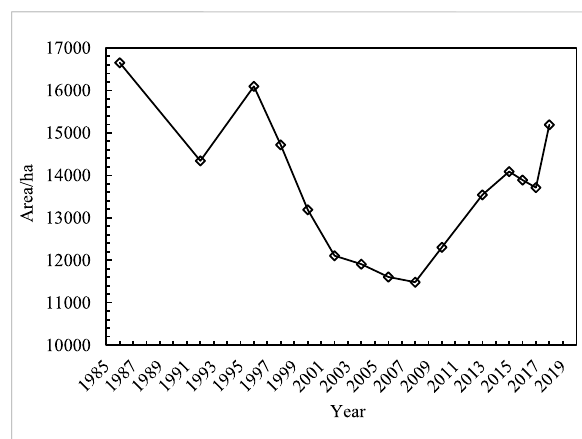
FIGURE 10 Variation of reed marsh area in the Yellow River